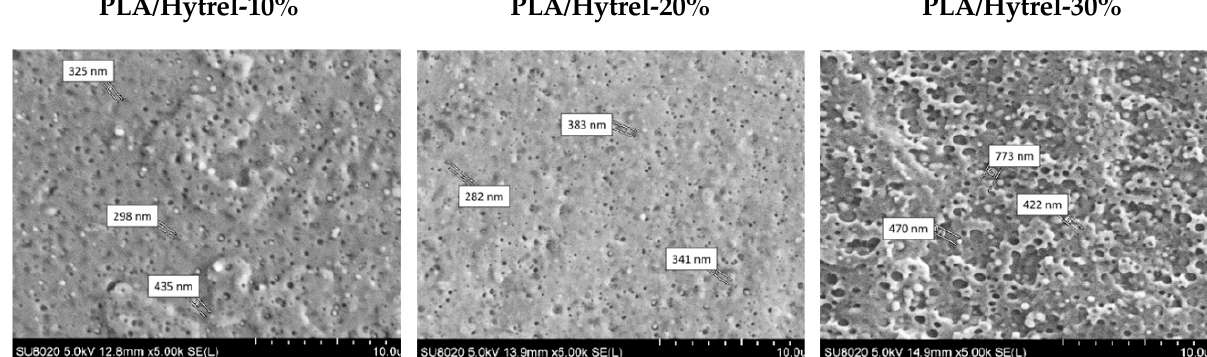
Figure 4. Crystallinity percentage calculated from the first thermal cycle (DSC) of the impact test samples that were based on PLA/Hytrel blends.